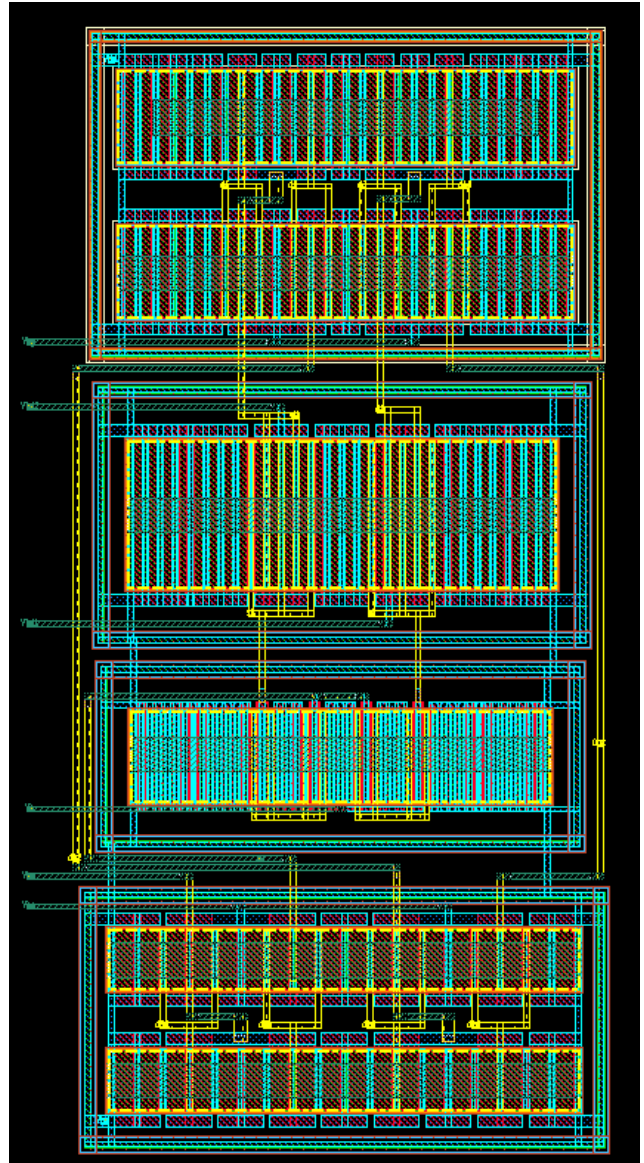
Figure 10. Layout of the OTA providing g m = 500 µ A/V.